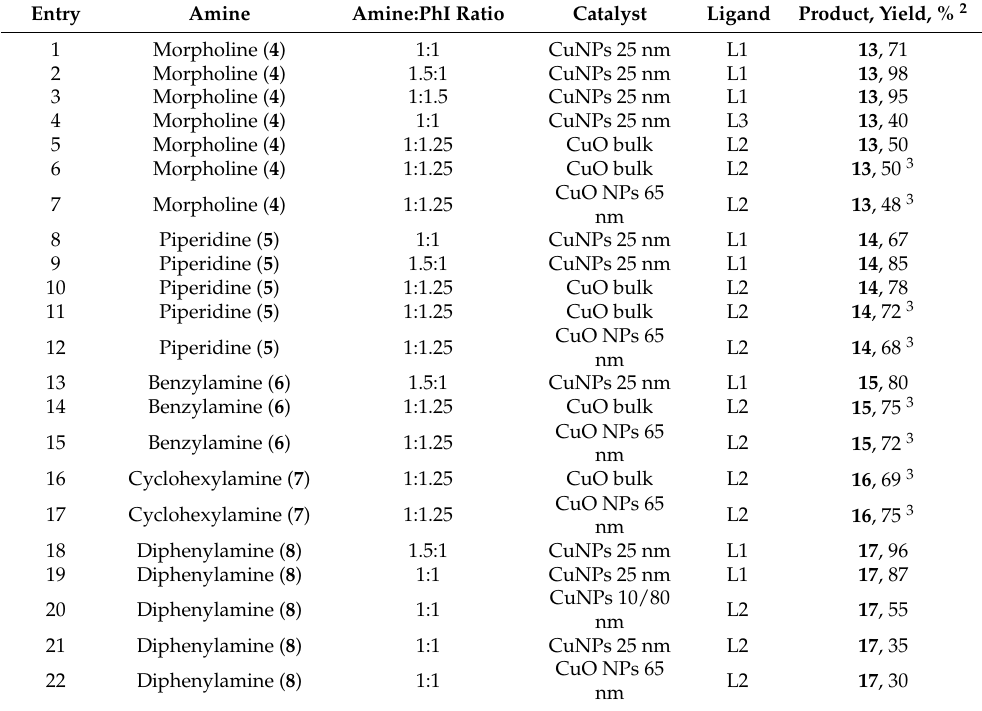
Table 4. Copper-catalyzed arylation of the amines 4–8 with iodobenzene 1 .